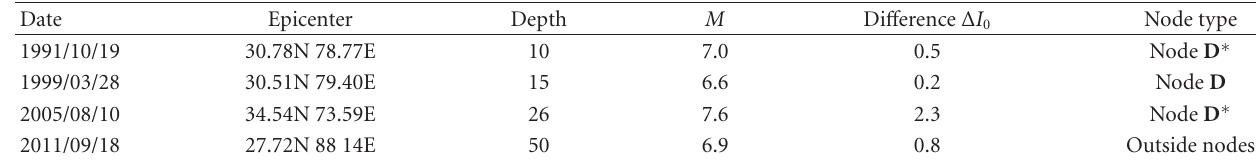
Table 3: Post-publication events and their correlation with